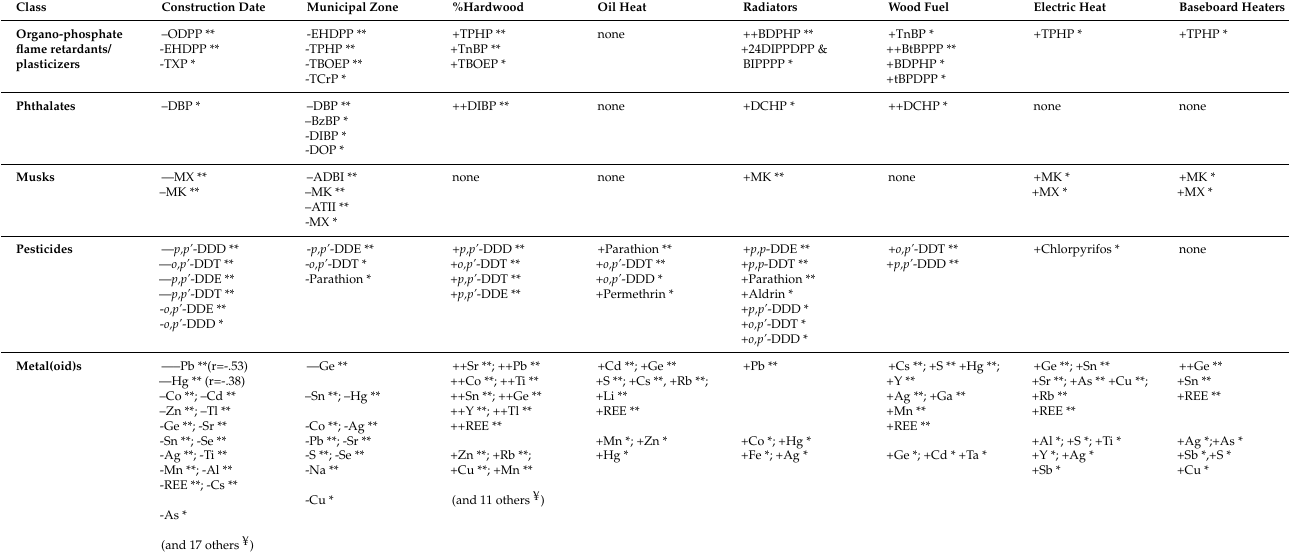
Table 4. Selected contaminants associated with increasing house age and/or proximity to the urban core, and related building characteristics, identified using Spearman rank analysis a . Negative correlations with construction date indicate that concentrations increase with increased house age; negative correlations with municipal zone indicate concentrations increase towards the urban